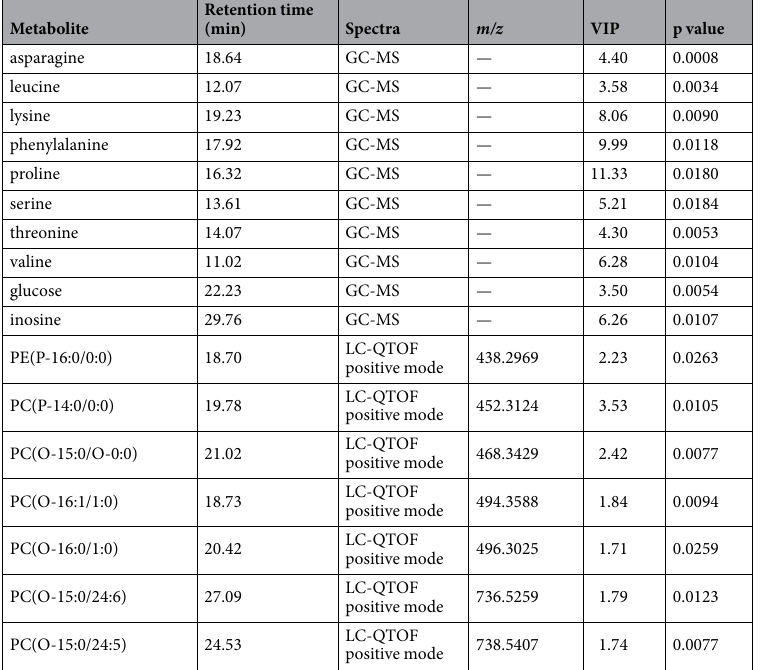
Table 3. Differentiating metabolites after acute exposure identified from GC-MS and LC-QTOF